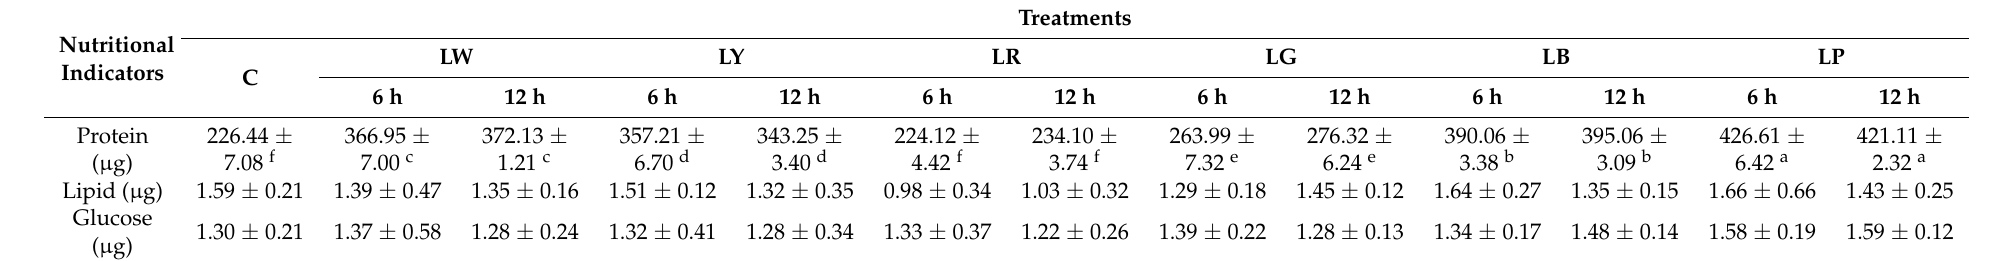
Table 4. Body composition of Goniopora columna after 8 weeks of daily exposure to different light sources for 6 or 12 h.